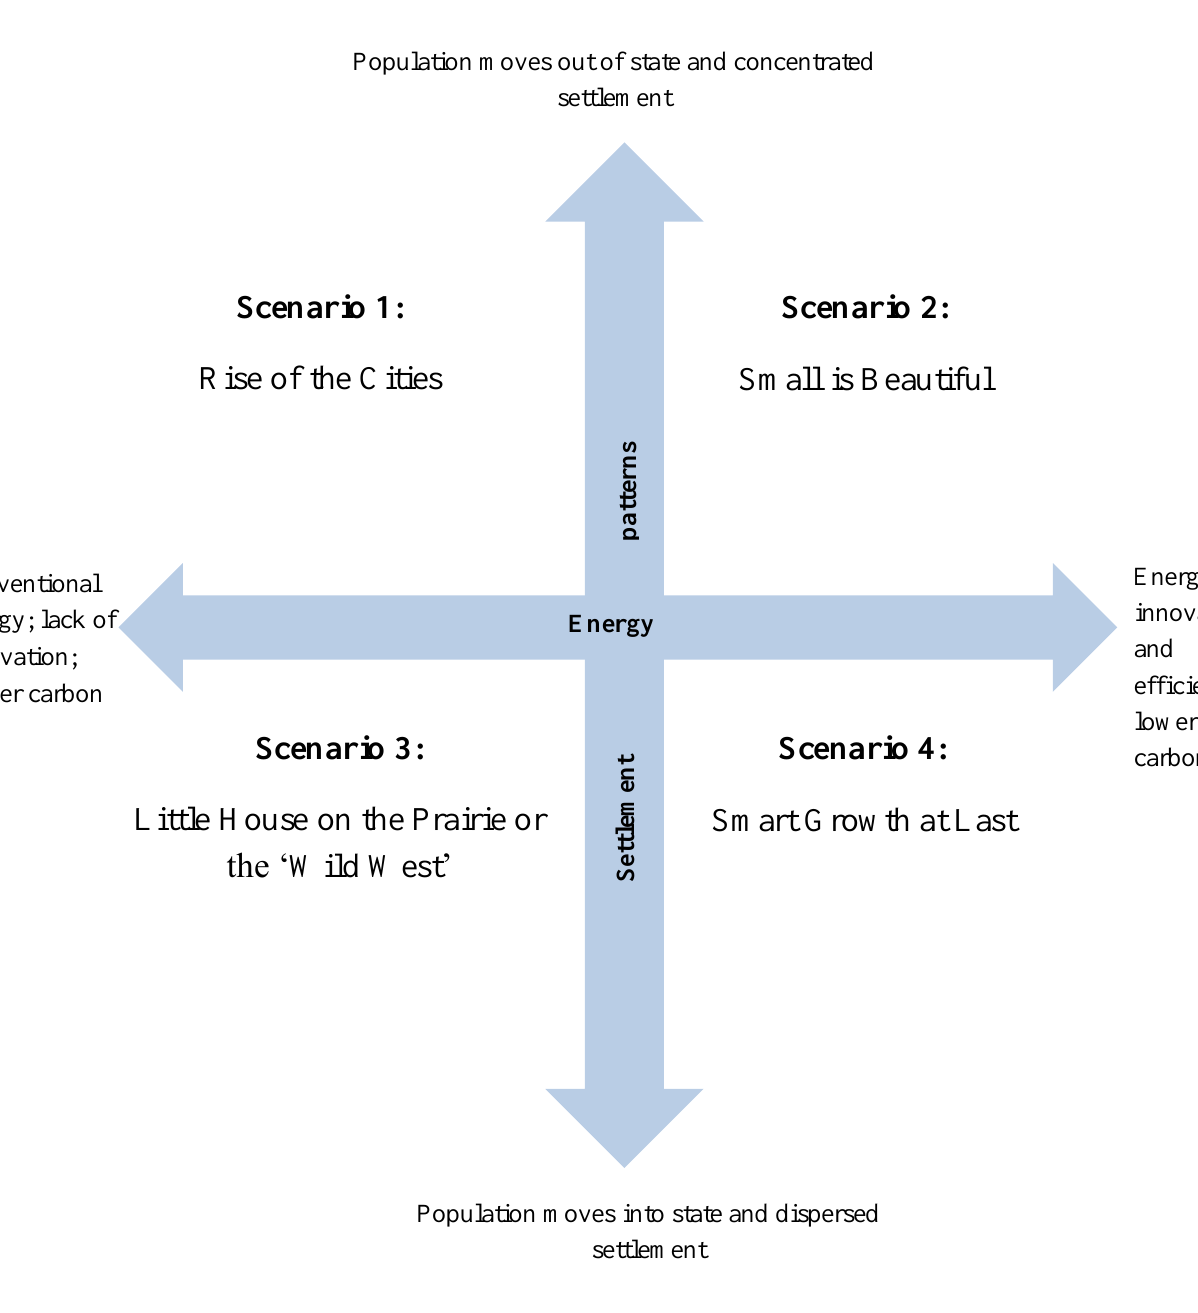
Fig. A2.6. New Hampshire scenario